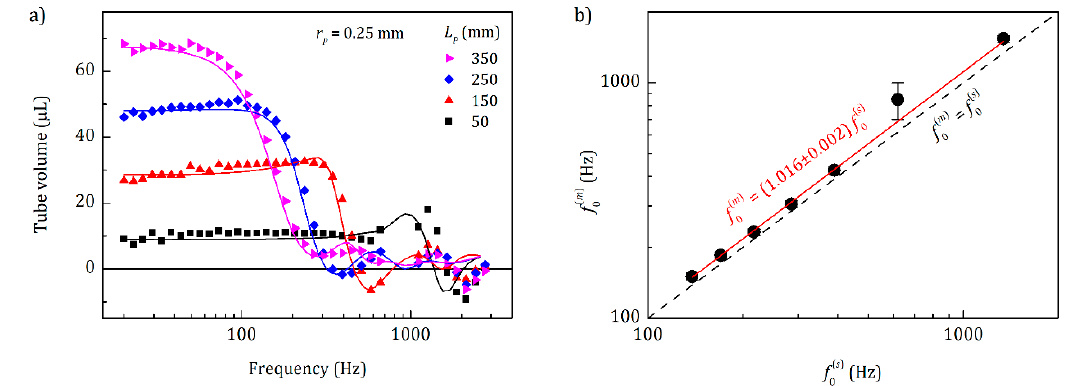
Figure 5. Comparison of measured and simulated results. ( a ) Internal volume of a Teflon tube closed at one side, measured at different frequencies. The inner radius of the tube was r p = 0.25 mm and its length L p varied from 50 to 350 mm. Solid lines reflect simulated results using COMSOL Multiphysics with CFD module. ( b ) Measured transition frequency versus simulated transition frequency. The black dashed line reflects a 1:1 dependence (right-black formula) and the red solid line is a linear fitting with fixed intercept resulting in the left-red formula.